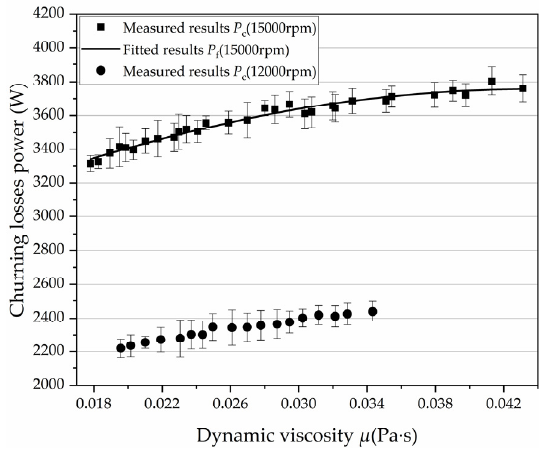
Figure 15. The variation law of churning losses power with oil viscosity.